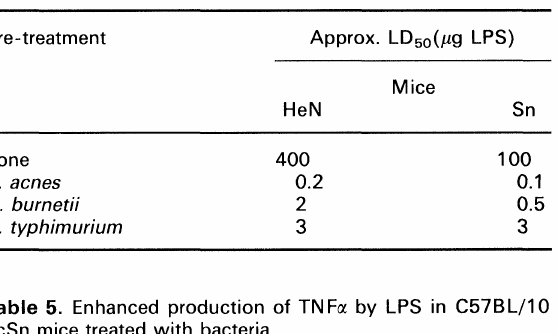
Table 4. Sensitivity of mice pretreated with different bacteria to the lethal effects of LPS